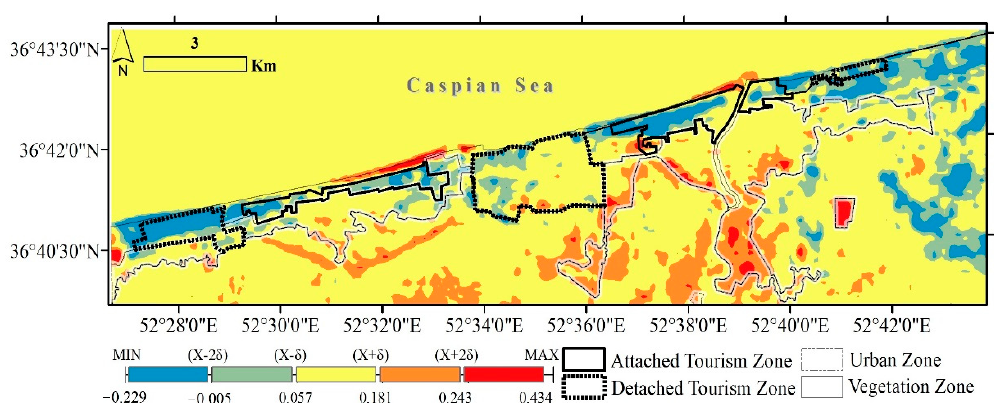
Figure 13. Spatiotemporal pattern of the annual trend of LST changes from 1987 to 2019 in Babolsar and Fereydonkenar. There were two areas with unusually and very unusually low (colder) LST